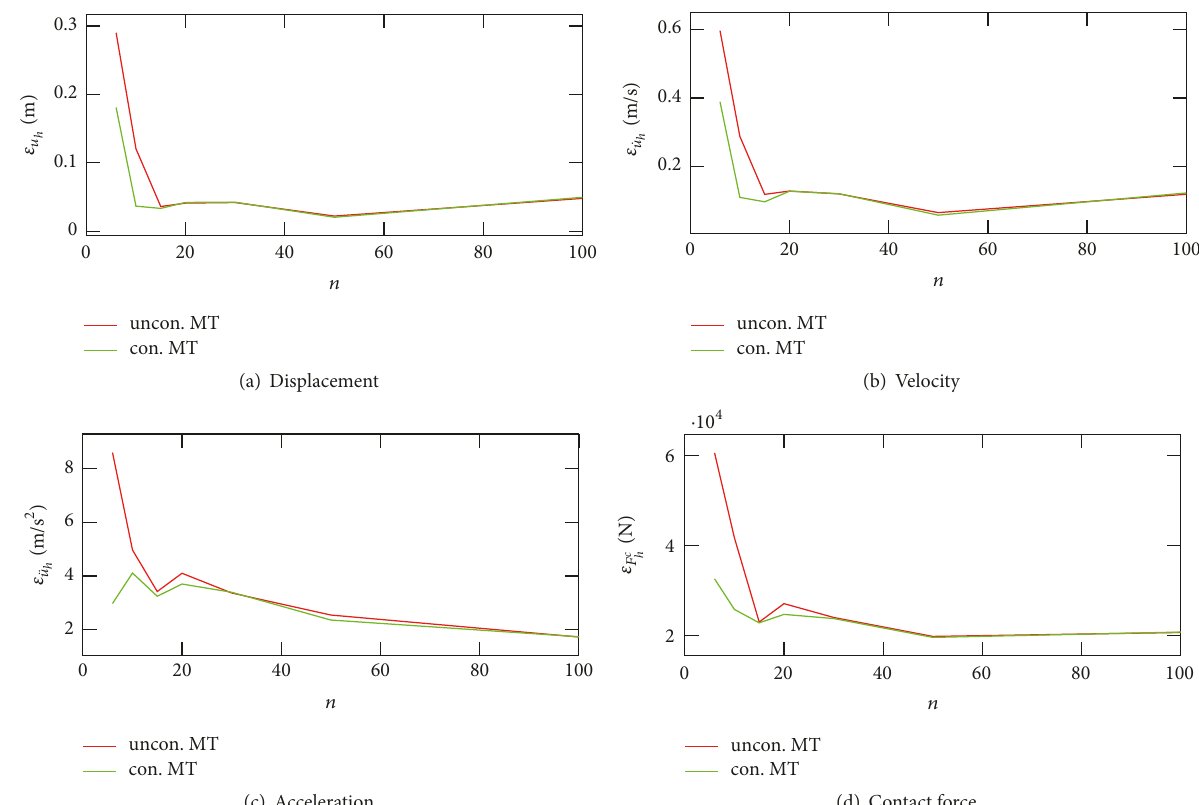
Figure 10: Error analysis using RMSD of the displacement, the velocity, and the acceleration as well as the contact force.